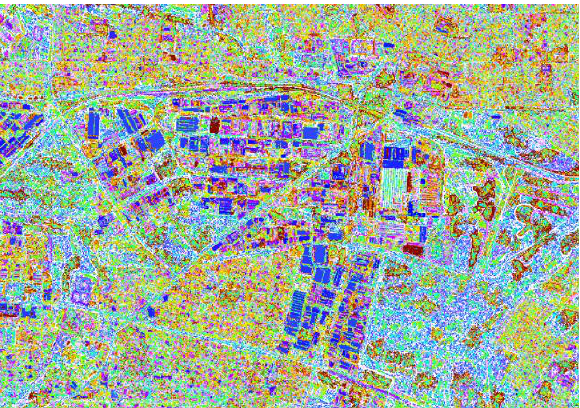
Figure 3. Radiometric feature extraction. The colours mark similar